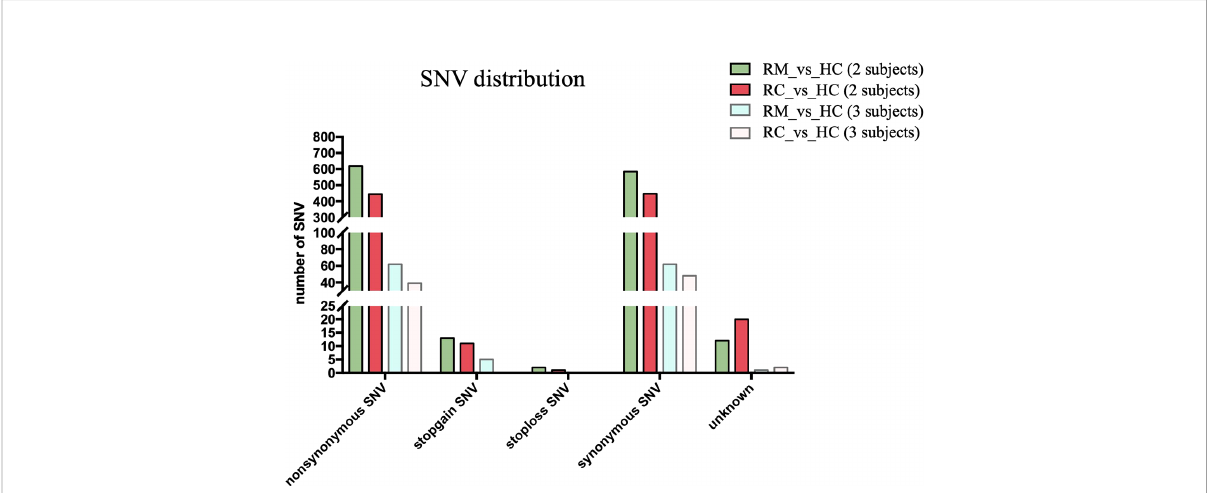
FIGURE 2 Identi fi cation of SNPs related to recurrence of FSGS after kidney transplantation. Bar plot showing summary of different types of SNP variants mapped to exons identi fi ed in PBMCs from recurrence (n ≥ 2) and remission (n ≥ 2) subjects excluding those also identi fi ed in HCs. RC, recurrence; RM, remission; HC, healthy